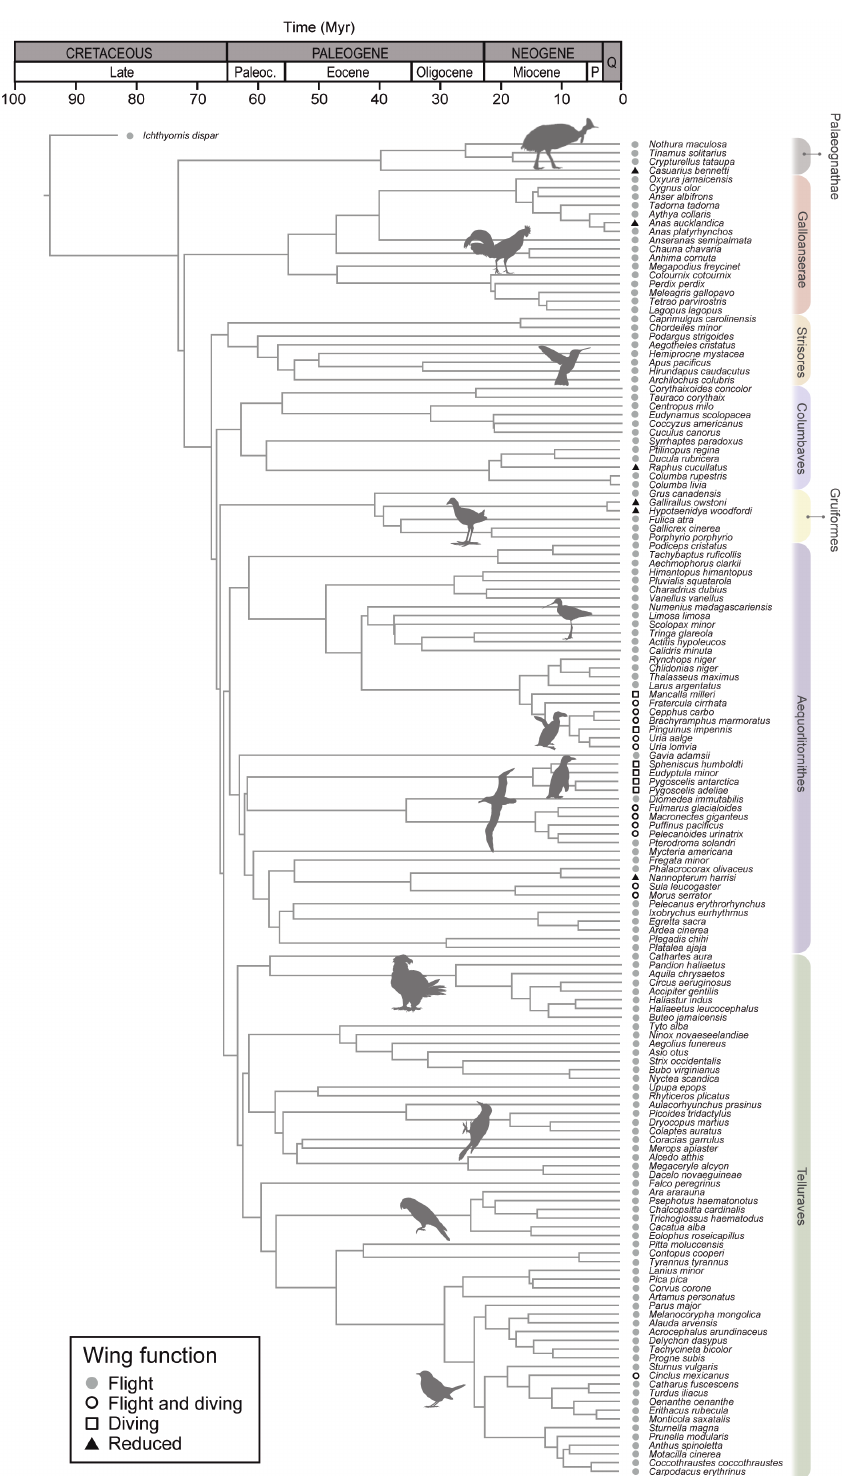
Figure 2. Time-calibrated phylogeny of the avian species used in this study (based on [33]) and their corresponding wing function